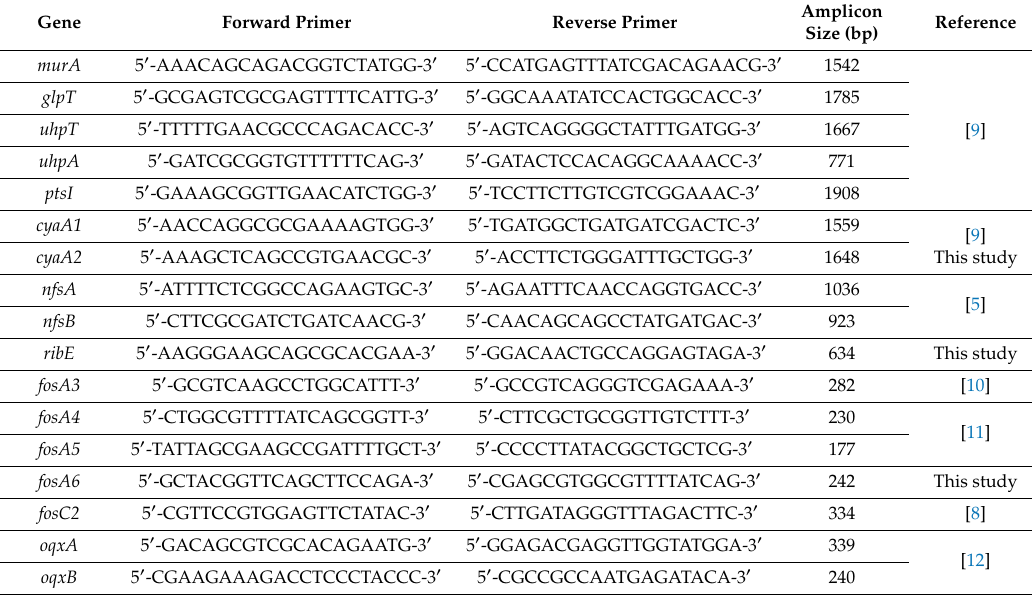
Table 1. Primers used for amplification and sequencing of the Escherichia coli genes involved in fosfomycin or nitrofurantoin